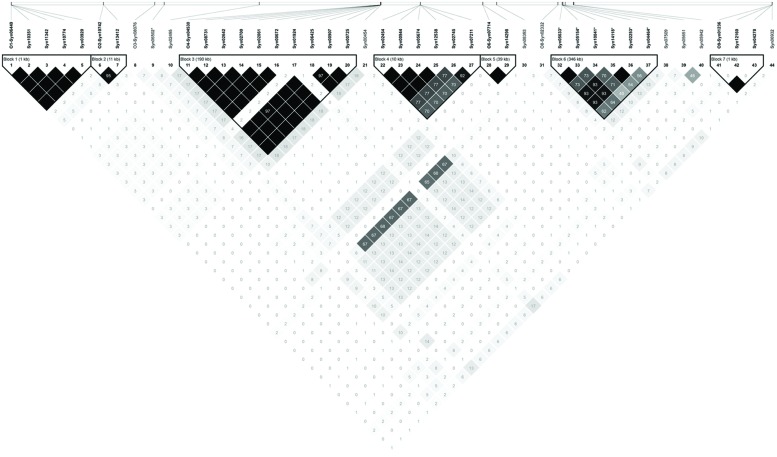
Linkage disequilibrium plot showing LD patterns among significant SNPs for temperature-related curd induction. The LD between the SNPs is measured as r2 and shown (×100) in the square at the intersection of the diagonals from each SNP. r2 = 0 is shown in white, 0 < r2 < 1 is shown in gray and r2 = 1 is shown in black. The analysis track at the top shows the SNPs according to their chromosomal location; while separating linkage groups by O1-, O2-, O3-, O4-, O6-, O8-, and O9- prefix, respectively. Seven haplotype blocks (outlined in bold black line) indicate markers that are in high LD.